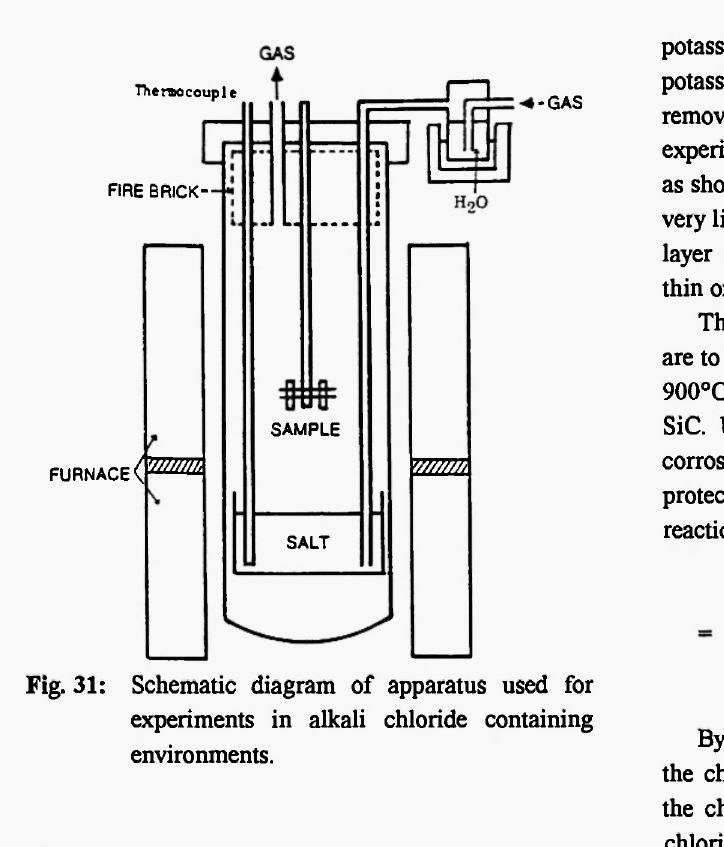
Fig. 31: Schematic diagram of apparatus used for experiments in alkali chloride containing environments.